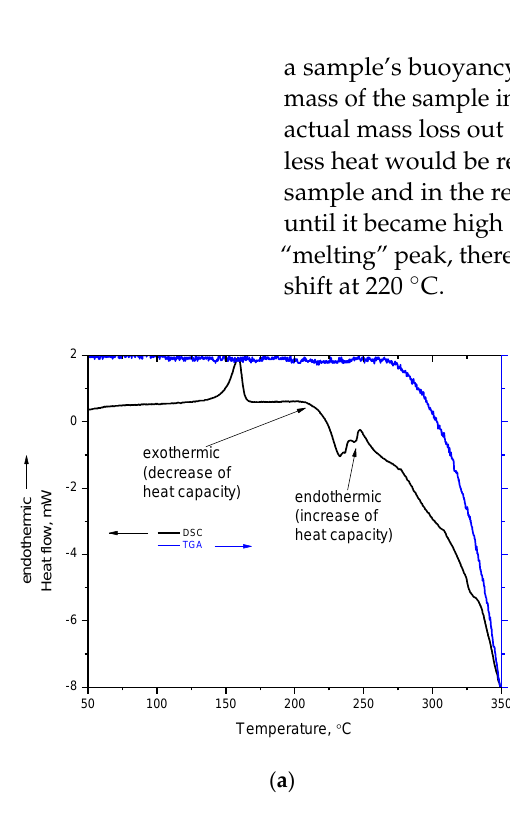
Figure 7. ( a ) DSC and TGA curve of isotactic PP up to 350 °C; ( b ) Photograph of the DSC pan at the end of the measurement up to 350 °C revealing the actual mass loss (brown/black color) which has occurred during the measurement.